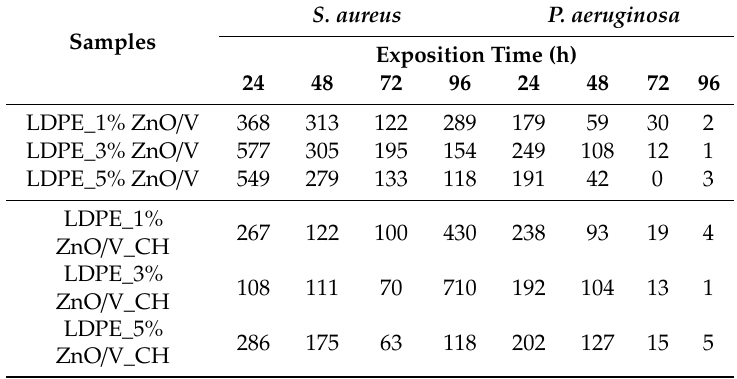
Table 2. E ffi ciency of individual antibacterial agents against S. aureus and P. aeruginosa.